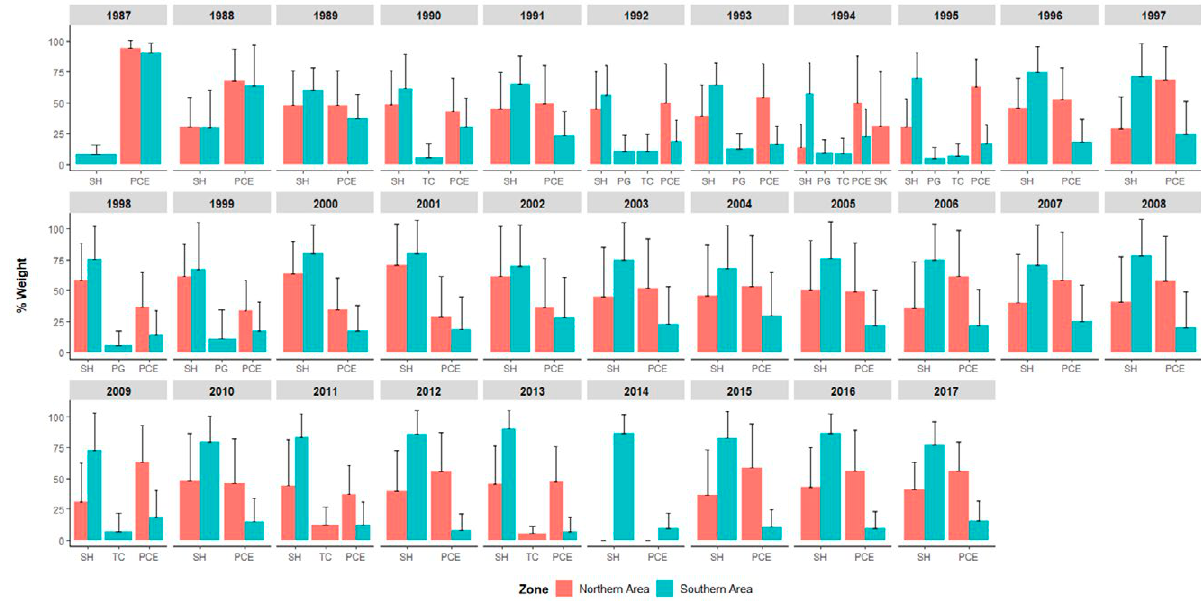
Fig. 4. – Annual average proportions of the main species (%weight >5%) caught in the pink cusk-eel fishery. Northern and southern refers to stock in the austral zone. SH, southern hake; PG, Patagonian grenadier; TC, tadpole codling; PCE, pink cusk-eel; SK, generic skates. Vertical lines indicate the standard